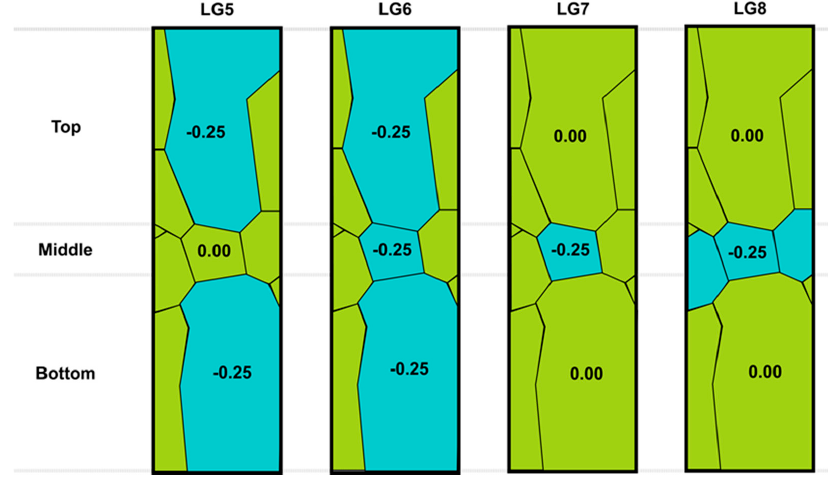
Figure 11. The grain orientations of the four considered cases (LG5 to LG8). Appl. Sci. 2020 , 10 , x FOR PEER REVIEW